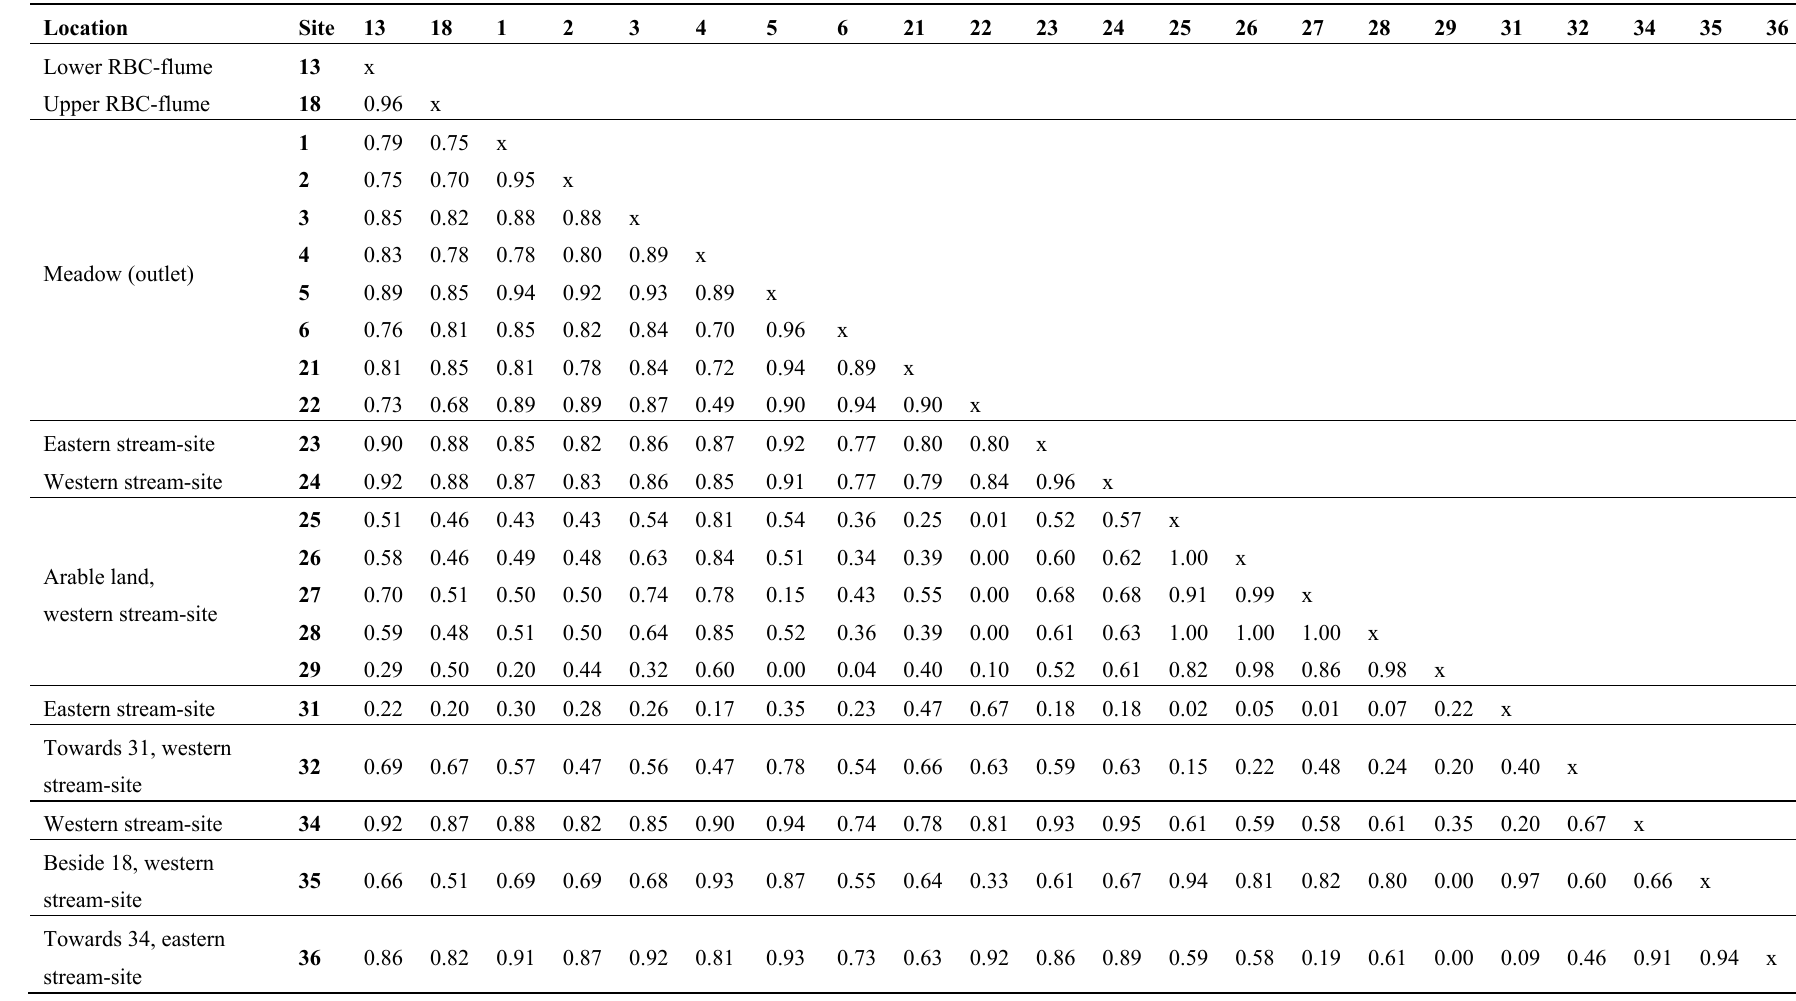
Table 4. Results of correlation analyses (R 2 ) among mean daily groundwater head elevations (m a.s.l.) of automatically monitored piezometers and mean daily discharge (L·s − 1 ). Correlations are classified into high (0.80 – 1.0, dark grey shaded), medium (0.60 – 0.79, lighter grey shaded), low correlations (0.40 – 0.59, light grey shaded), and no correlations (<0.39, no shading).